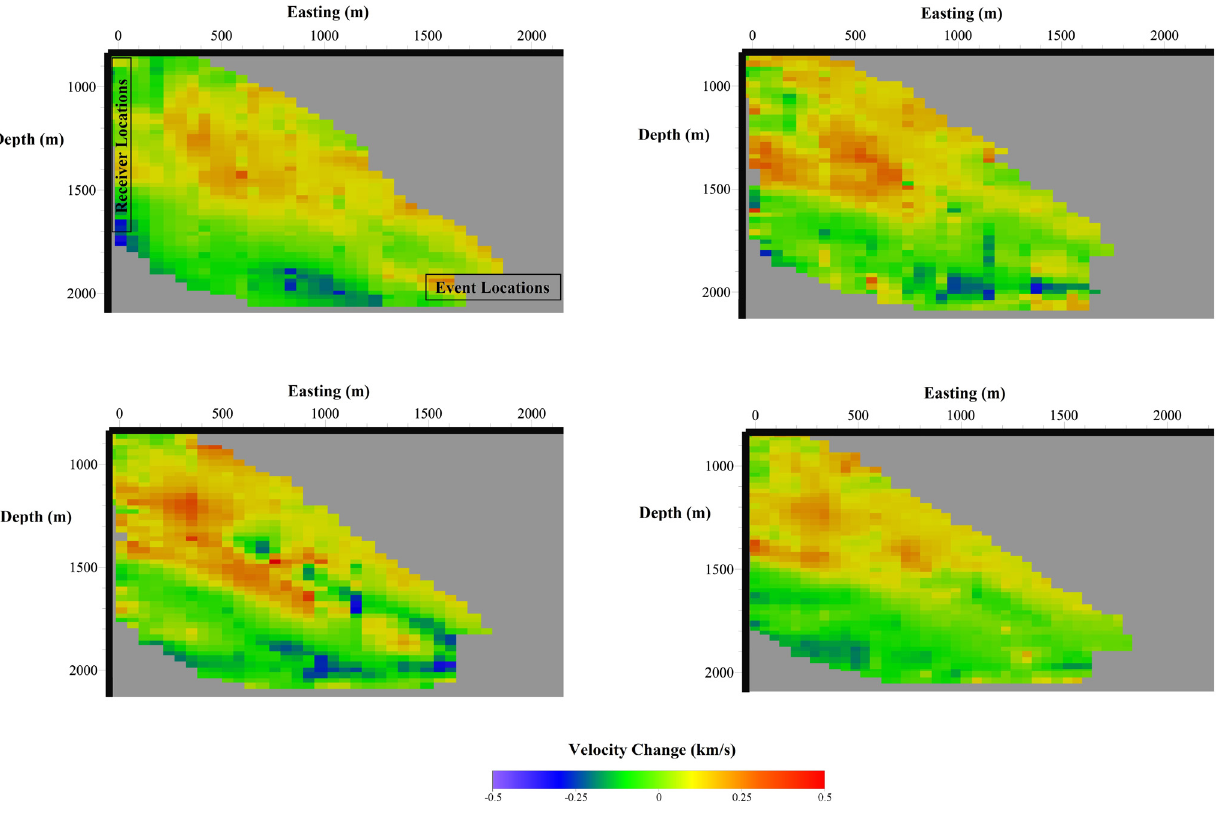
Figure 12. Tomograms showing velocity change between Time 1 and Synthetic Time 1 ( top left ), Time 2 and Synthetic Time 2 ( top right ), Time 3 and Synthetic Time 3 ( bottom left ), and Time 4 and Synthetic Time 4 ( bottom right ). Gray coloring represents no ray path coverage, and all tomograms are at the midpoint between the receivers and the centroid of the event cluster, a northing slice of − 290